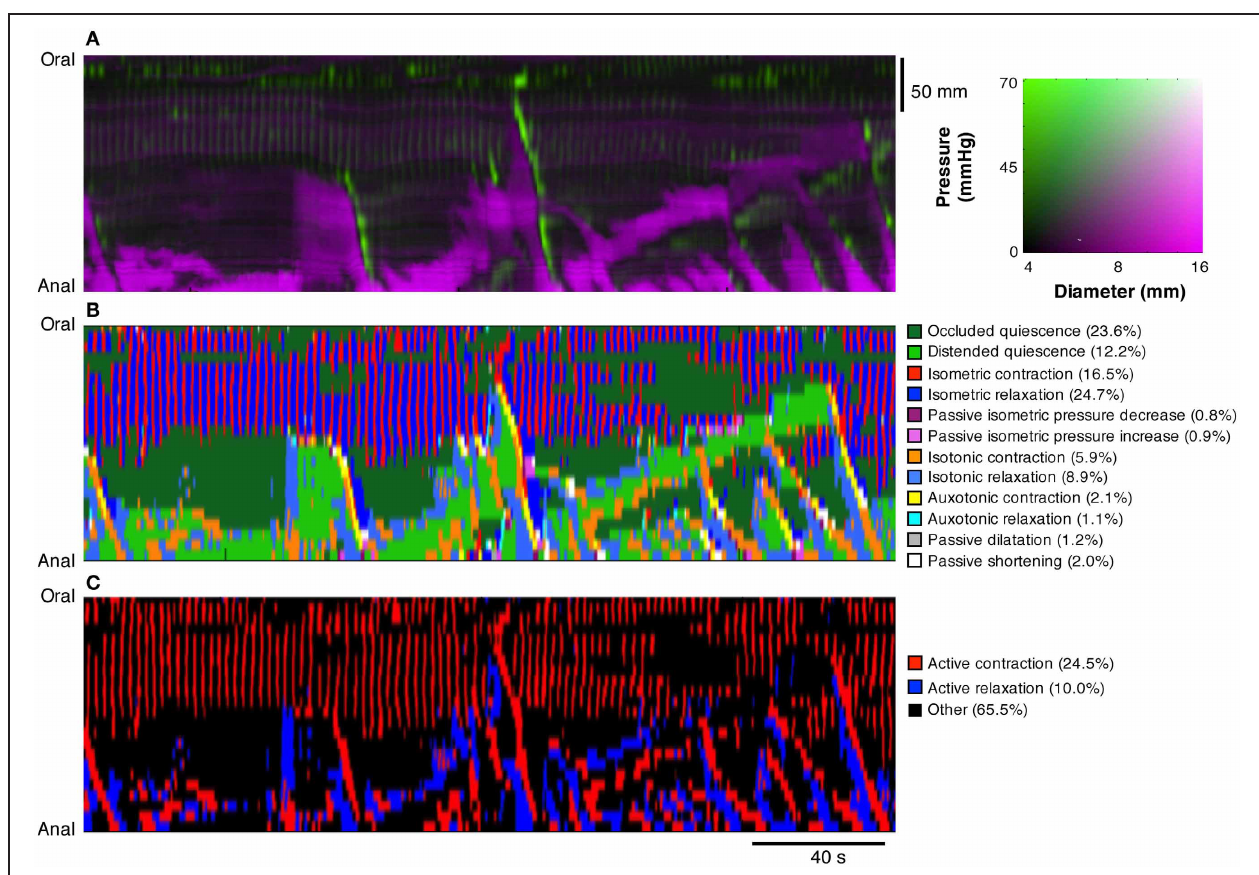
contraction during neural peristalsis. Active relaxation (aqua and light blue) precedes both in time and space the propagating contraction. The regular myogenic activity in this example consists in isometric contractions and isometric relaxations. The last map (C) represents a simplification of the full composite map of states by clustering all areas undergoing active contraction (red) and, active relaxation (blue). All other passive states are in black. The spatio-temporal nature of active contractions and relaxations during neurogenic activity and myogenic activity is made very